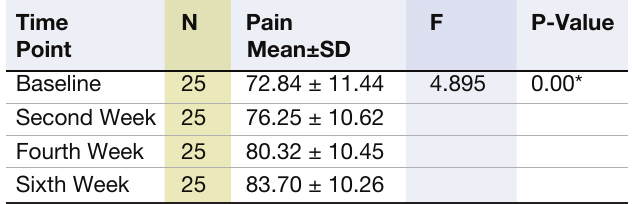
Table 6. Physical Function Scores of Participants in the Tele- physiotherapy Group across Baseline, Second, Fourth and Sixth Week of Intervention